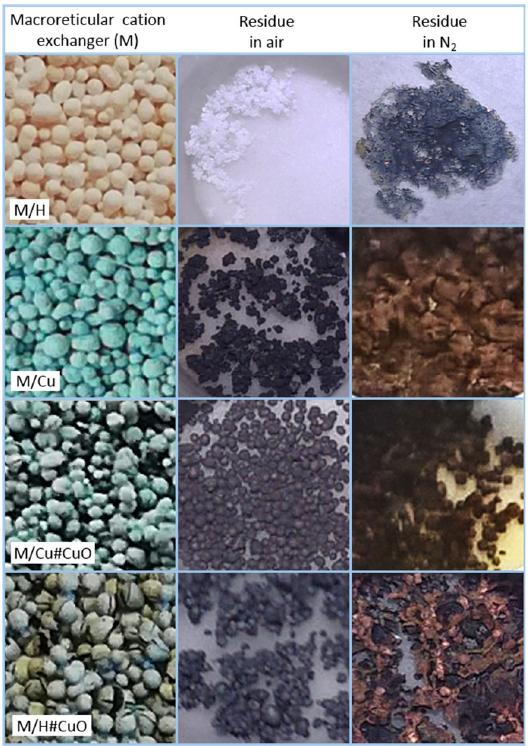
Figure 1. Photographs of examined materials based on macroporous carboxylic cation exchanger (left column), solid residues after their thermal analysis in air (middle column) and in N 2 (right column).